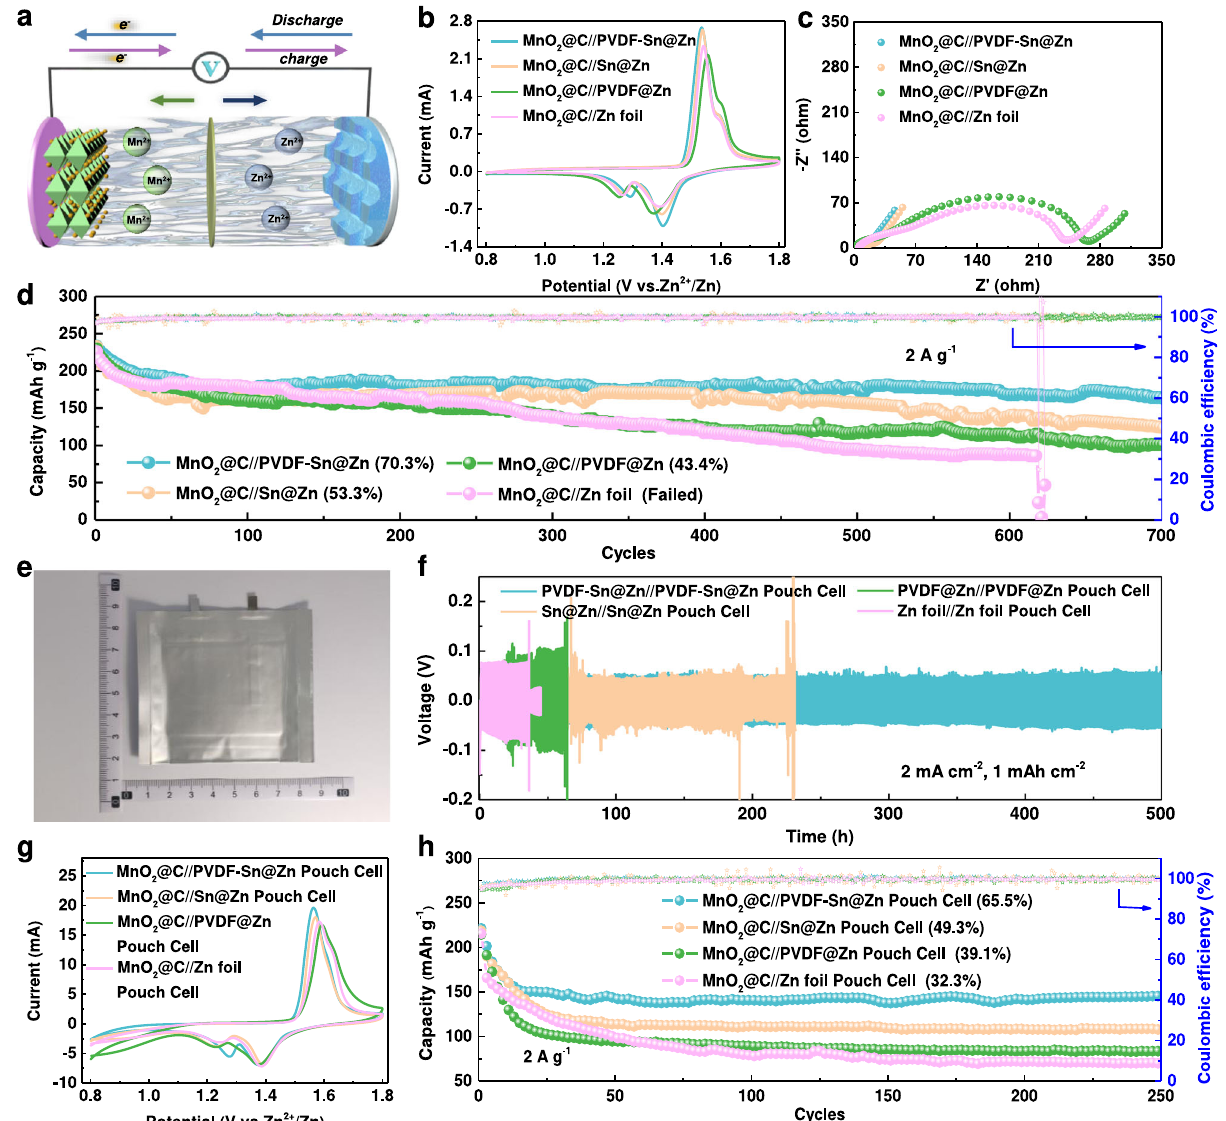
Fig.6|Electrochemicalperformanceoffullcellsandpouchcells.a Schematicof the Zn-ion battery device. b CV curves during the second cycle, c EIS plots, and d long-term cycling stability at a speci fi c current 2Ag − 1 of different full